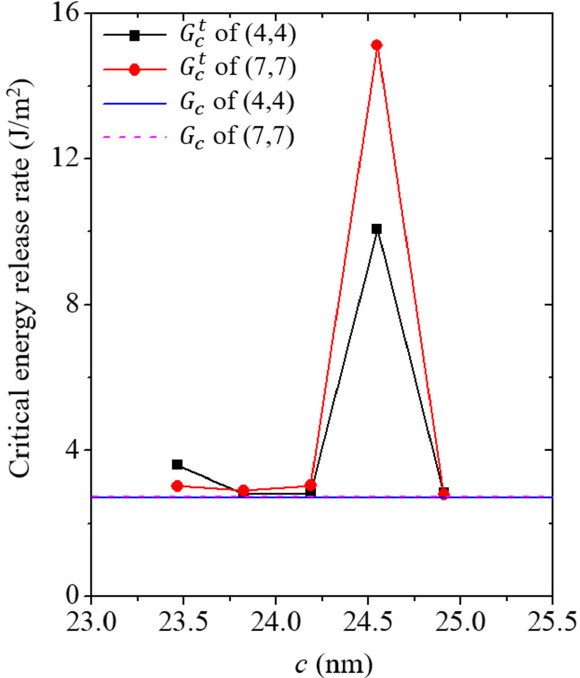
Figure 7. Strain energy of the (7,7) CNT model with various crack lengths corresponding to the tensile strain. c denotes the crack length in the model.